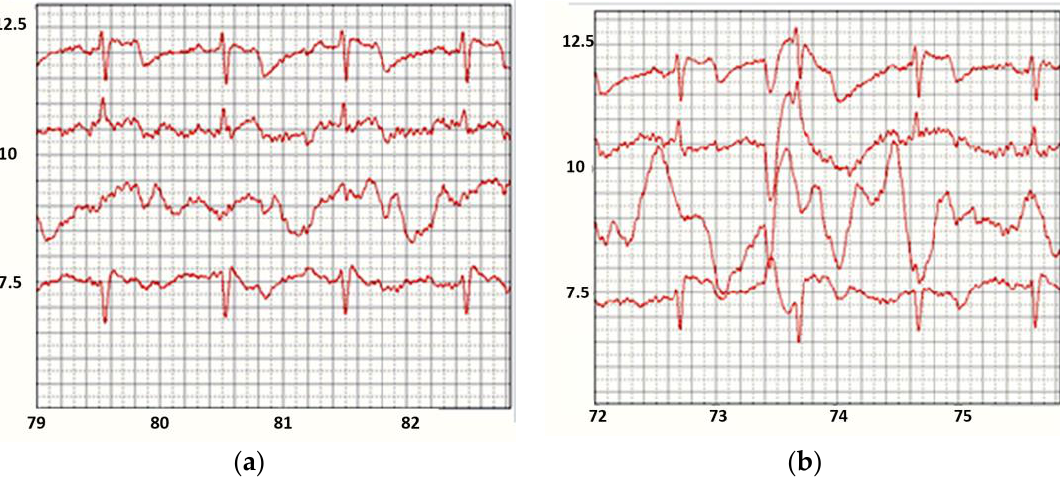
Figure 9. Signals from the recorder leads on the chest and back registered during normal ( a ) and deep ( b ) breathing.